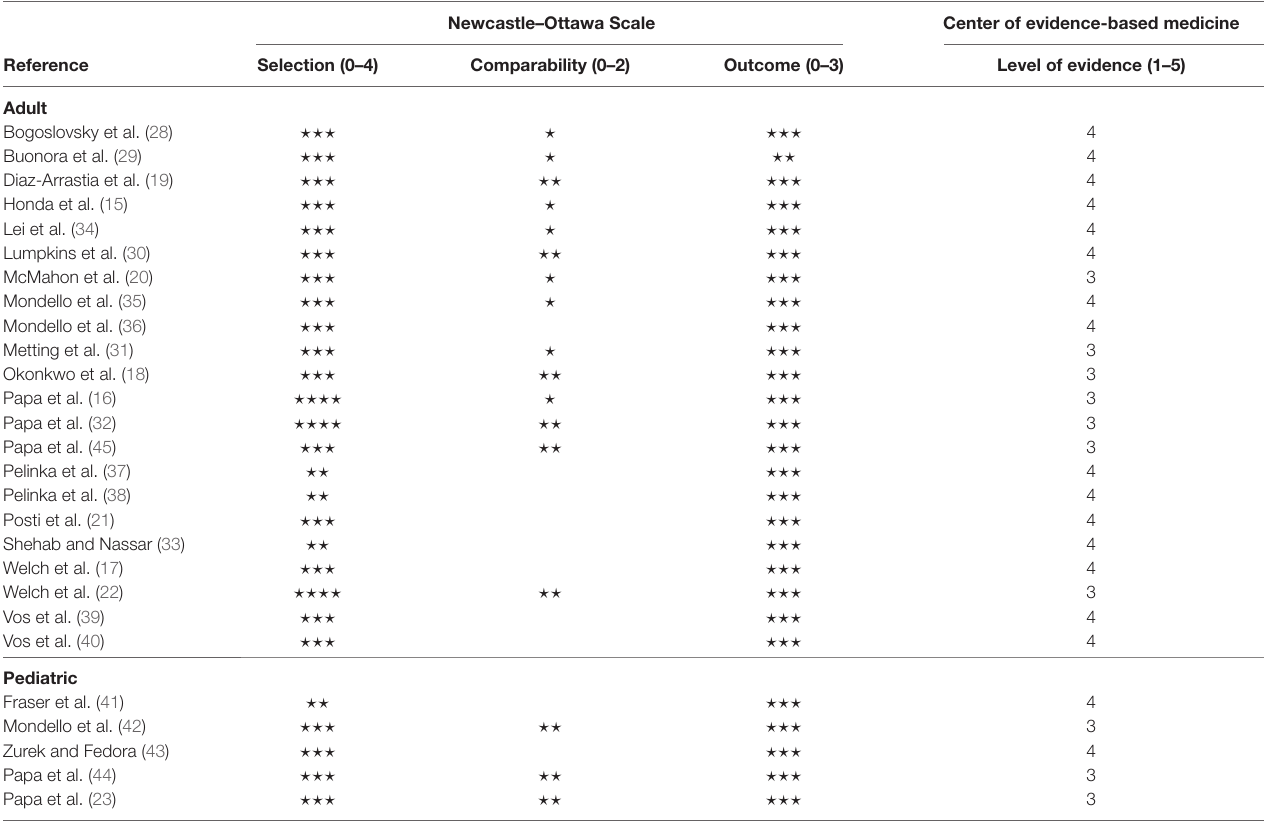
taBLe 2 | The Newcastle–Ottawa Scale scores and the level of evidence of the included